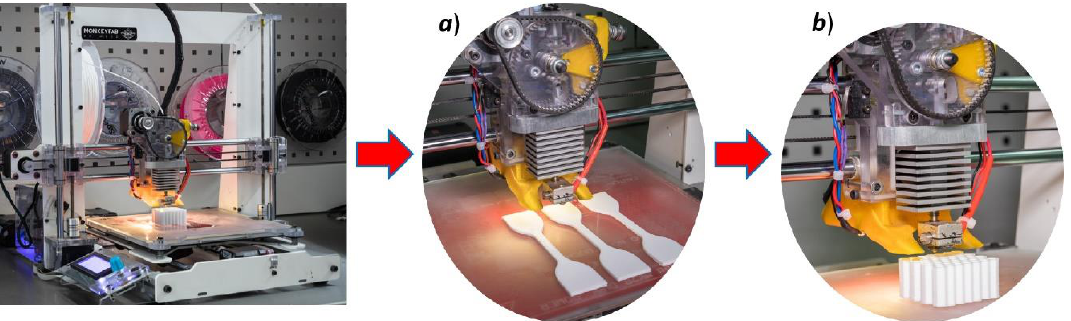
Figure 4. The general view of used 3D printer-Prime 3D (MonkeyFab) during the fabrication process of: ( a ) Dog bone samples, ( b ) structure specimens. Table 1. Geometrical specifications of developed lattice structures.